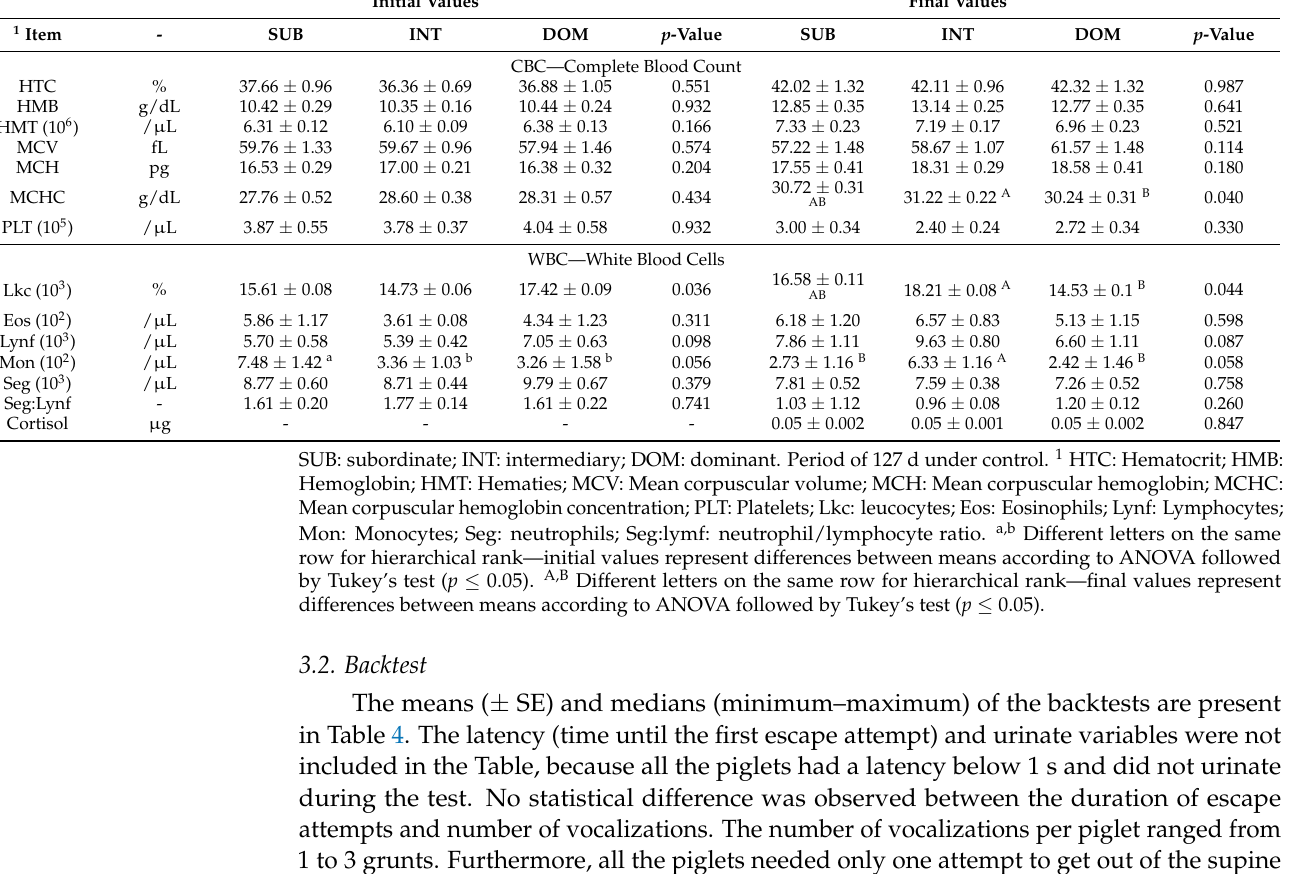
Table 3. Initial and final average blood count (mean ± SE) and cortisol samples (mean ± SE) of growing and finishing pigs based on dominance sociomatrix classification. Initial